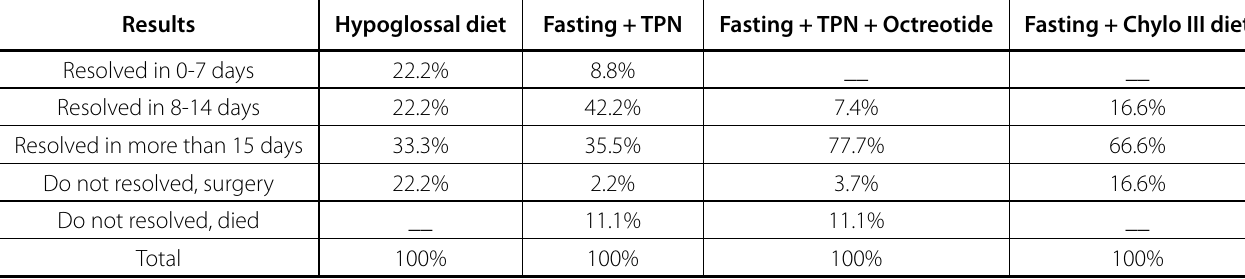
Table 4. Association between outcome and used strategy.